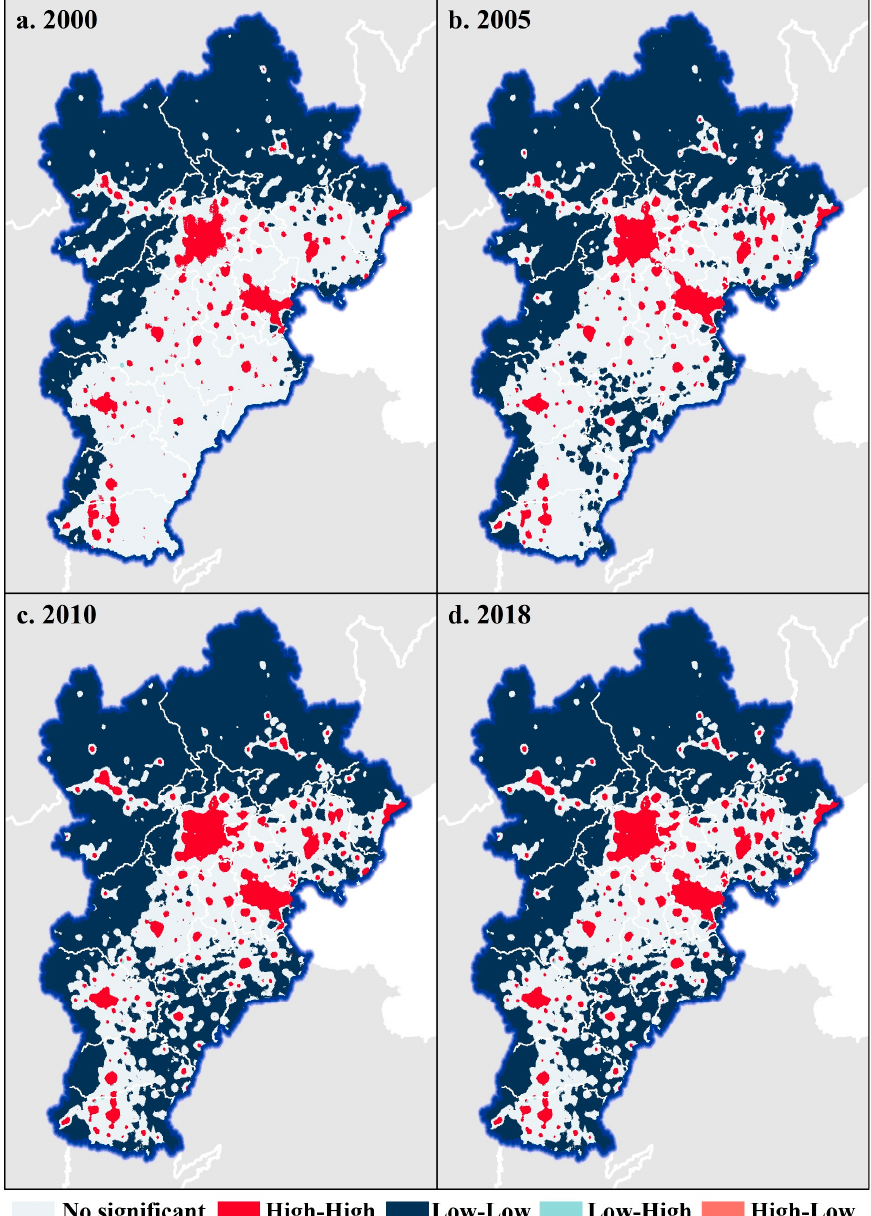
Figure 6. Spatial cluster maps for indirect emissions in Beijing–Tianjin–Hebei from 2000 to 2018 (High–High: high-value clusters; Low–Low: low-value clusters; Low–High/High–Low: there is a distribution of both high-value and low-value clusters).